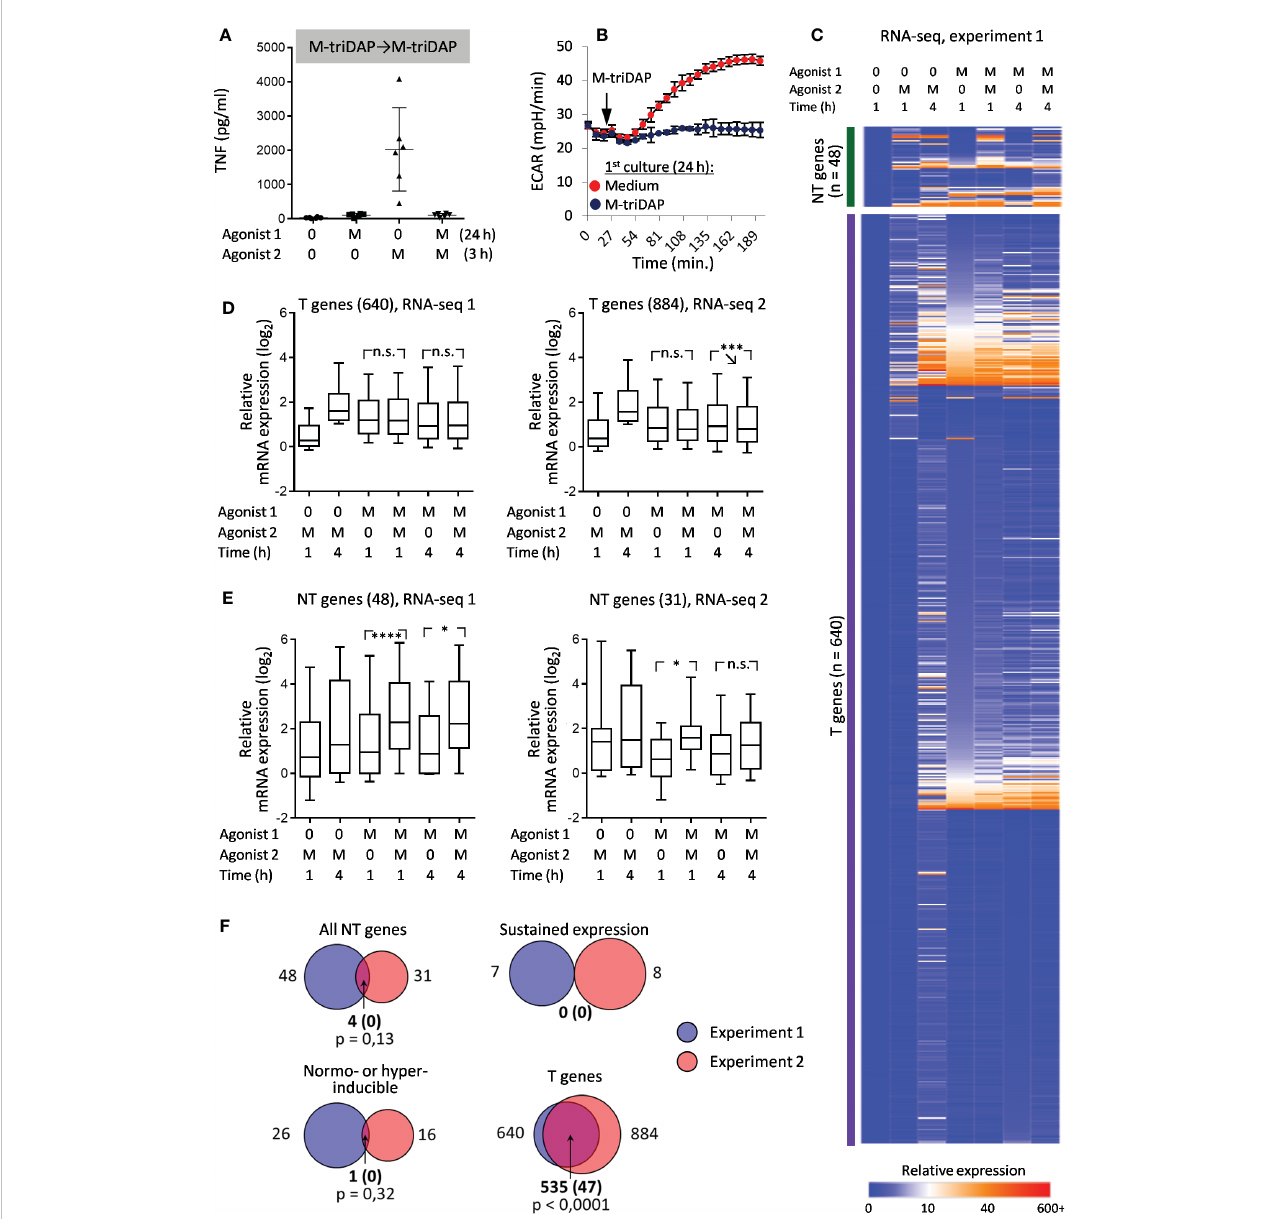
FIGURE 5 Responses of M-triDAP-tolerized macrophages to M-triDAP restimulation. Macrophages were cultured for 24 h with M-triDAP (M) or medium alone (0), washed and recultured without or with M-triDAP for indicated periods of time. (A) Levels of TNF in supernatants of naïve and M-triDAP-tolerized macrophages after restimulation with M-triDAP (ELISA, 6 experiments, M± s ). (B) Kinetics of ECAR of naïve and M-triDAP-tolerized macrophages after addition of M-triDAP (1 representative experiment out of 6, M± s of quadruplicate wells). (C) Heat map of relative gene expression (RPM sample /RPM baseline ) in RNA-seq experiment 1. (D, E) Statistics of relative gene expression (log 2 -transformed) of T genes (D) and all NT genes (E) in RNA-seq experiments 1 and 2. (F) Sizes of T, NT, SE and NH gene sets identi fi ed in RNA-seq experiments 1 and 2, and their intersections (numbers of genes). Shown in parentheses are expected numbers of coincidences if they were purely random. Statistical analysis as in Figures 2 and 3. *p < 0.05, ***p < 0.001, ****p < 0.0001, n.s. = non-signi fi